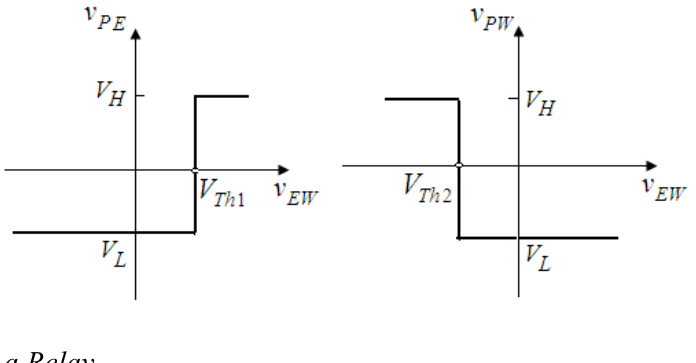
Figure 6. Voltage transfer characteristics of the open-loop